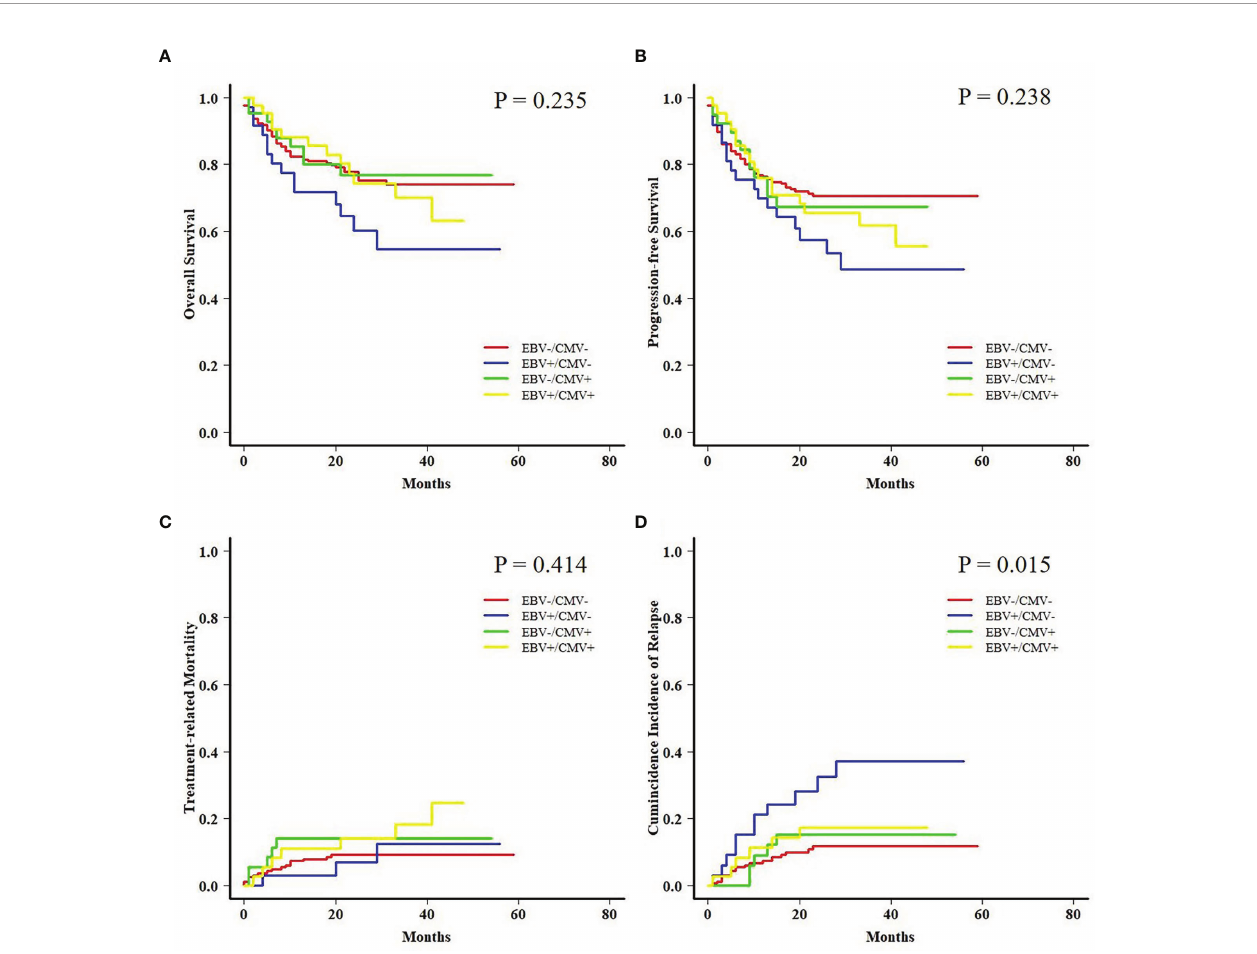
FIGURE 1 | Transplant outcomes among subgroups based on viral reactivation in acute myeloid leukemia (AML) patients. (A) Overall survival (OS) among subgroups based on viral reactivation in AML patients. (B) Progression-free survival (PFS) among subgroups based on viral reactivation in AML patients. (C) Treatment-related mortality (TRM) among subgroups based on viral reactivation in AML patients. (D) Cumulative incidence of relapse (CIR) among subgroups based on viral reactivation in AML